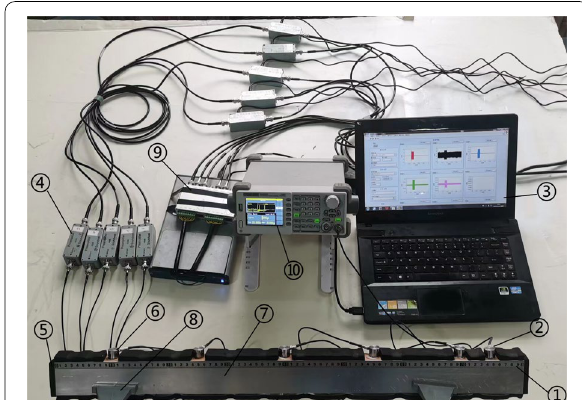
Fig. 2 Schematic diagram of the test scheme. ① Ruler ② AE source ③ AE signal acquisition computer ④ PAI front-end amplifier ⑤ Sound-absorbing cotton ⑥ Sensors ⑦ Aluminum plate ⑧ Vise ⑨ NI acquisition card ⑩ Arbitrary waveform